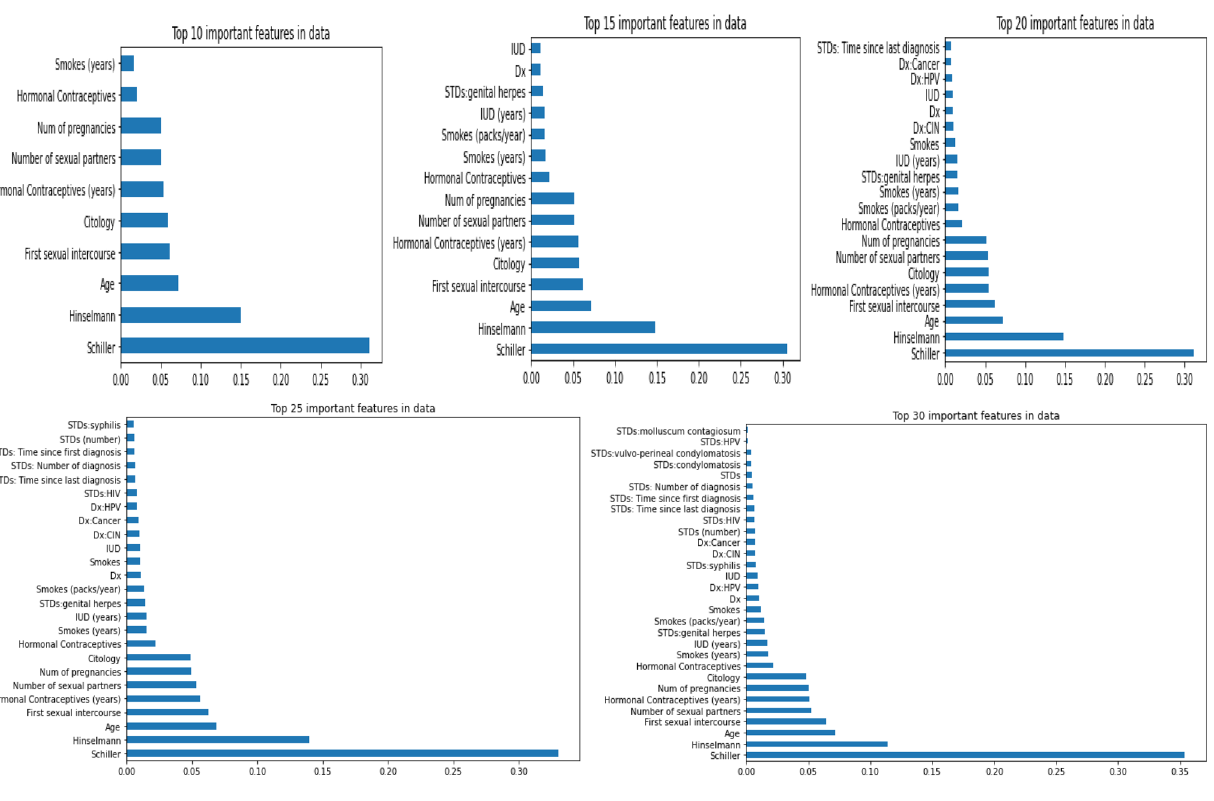
Fig. 2 Various top features